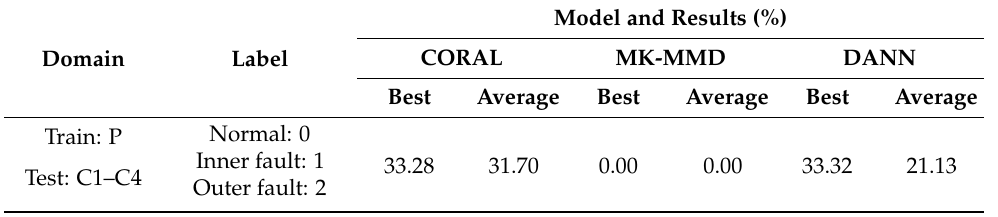
Table 5. Classification results of case 2.